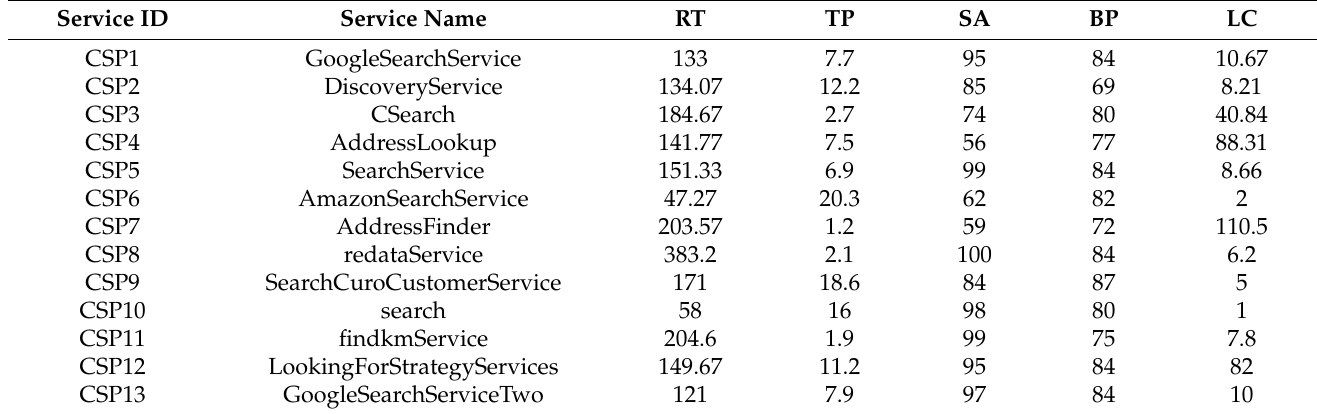
Table 2. The dynamic QoS indicator values for 13 selected services.